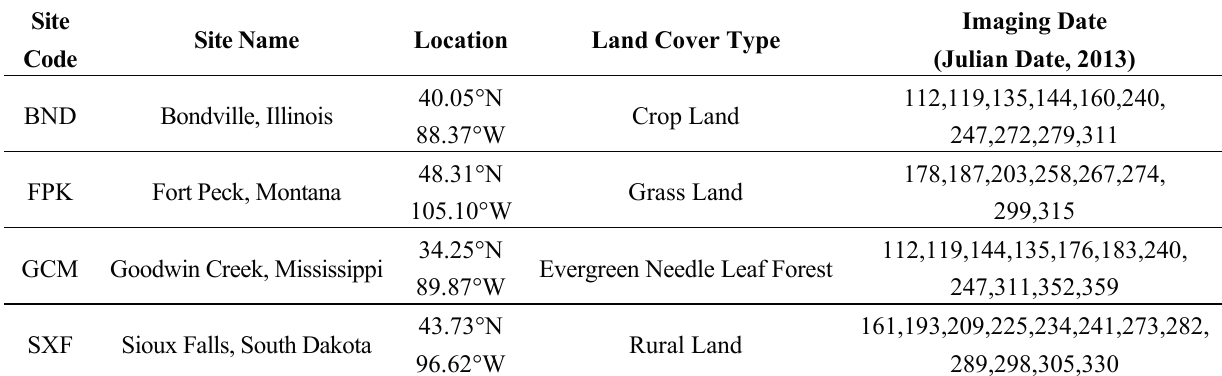
Table 5. Four Surface Radiation Budget Network (SURFRAD) sites’ information and corresponding imaging